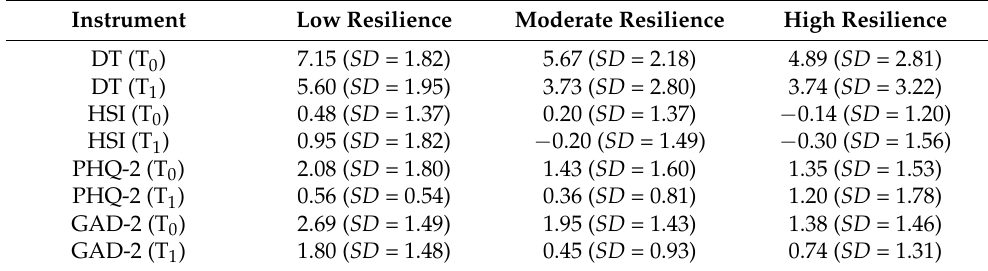
Table 5. Mean scores for distress, need for psychosocial support, depression, and anxiety by level of resilience.